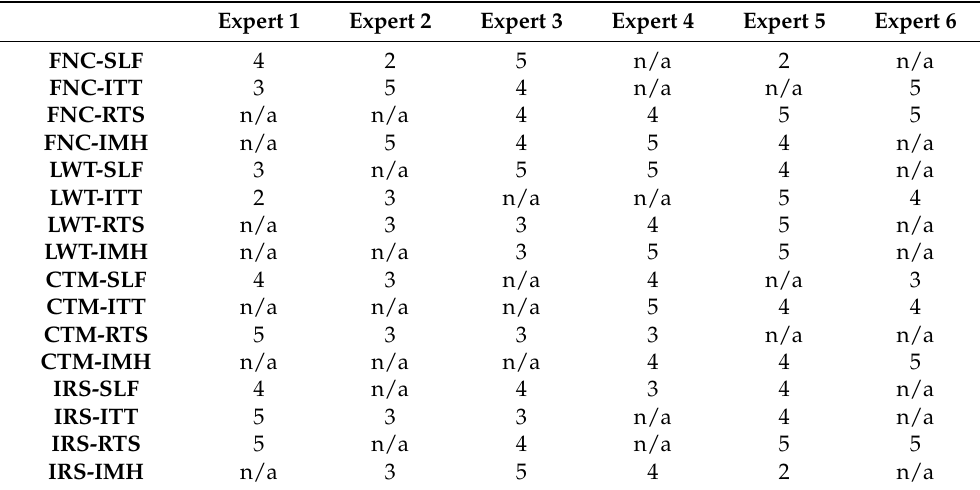
Table A3. The preference ratings of the experts for the decision matrix of the competencies.